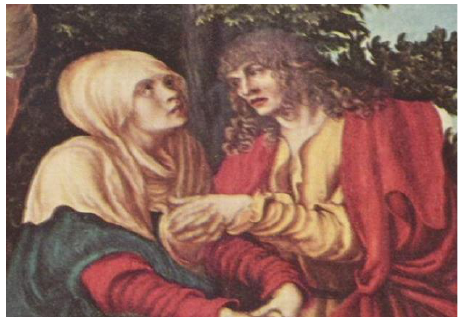
Figure 2. The Lamentation of Christ , detail, painted in 1503 (Figure 2, in black paint on a piece of white paper painted as a tromp l ’ oeil at the bottom edge of the painting, 137.8 – 138 × 98.3 – 99.3 × 0.8 – 1.5 cm; https://lucascranach.org/en/DE_BStGS_1416/, accessed on 27 February 2023).